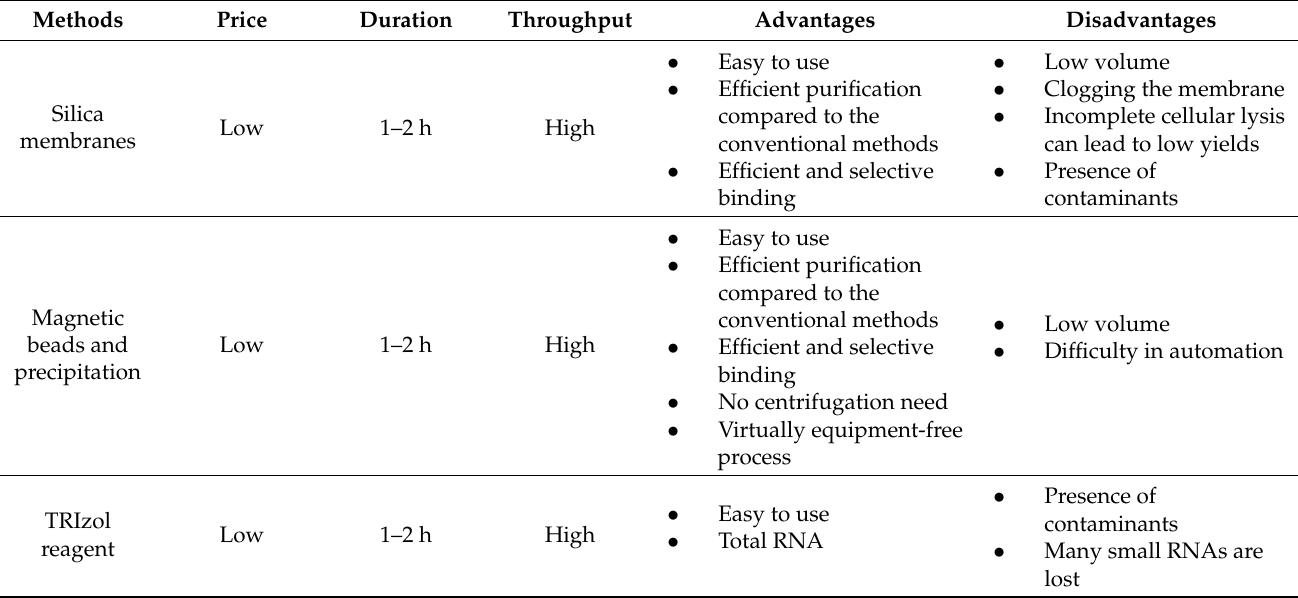
Table 2. Methods for cf-RNA